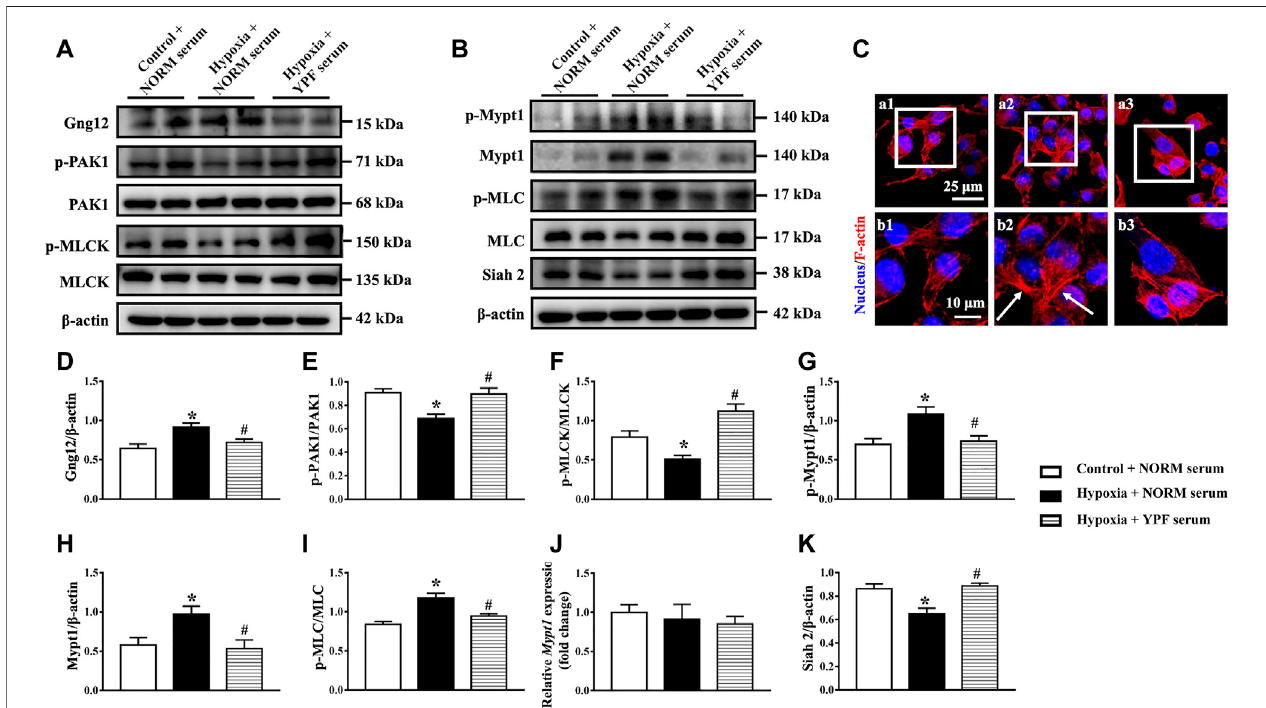
FIGURE 7 | YPF serum attenuates the alteration of MLC and related signaling proteins in PMVECs. (A) Representative Western bands of Gng12, p-PAK1, PAK1, p-MLCK,andMLCK. (B) RepresentativeWesternbandsofp-Mypt1,Mypt1,p-MLC,MLC,andSiah2. (C) RepresentativeF-actinstainingimages(red)inPMVECs.Nuclei stained blue. Arrows: stress fi bers. (a1,b1) Control + NORM serum; (a2,b2) hypoxia + NORM serum; and (a3, b3) Hypoxia + YPF serum. Upper scale bar = 25 μ M; lower scale bar = 10 μ M. (D – I) Semi-quantitative analysis of (D) Gng12, (E) p-PAK1/PAK1, (F) p-MLCK/MLCK, (G) p-Mypt1, (H) Mypt1, and (I) p-MLC/MLC . Resultsarepresentedasmeans±SEM(n=6). (J) mRNAexpressionofMypt1; n =8. (K) Semi-quantitativeanalysisofSiah2.Resultsarepresentedasmeans±SEM( n = 6). * p < 0.05 vs. control + NORM serum; # p < 0.05 vs. hypoxia + NORM